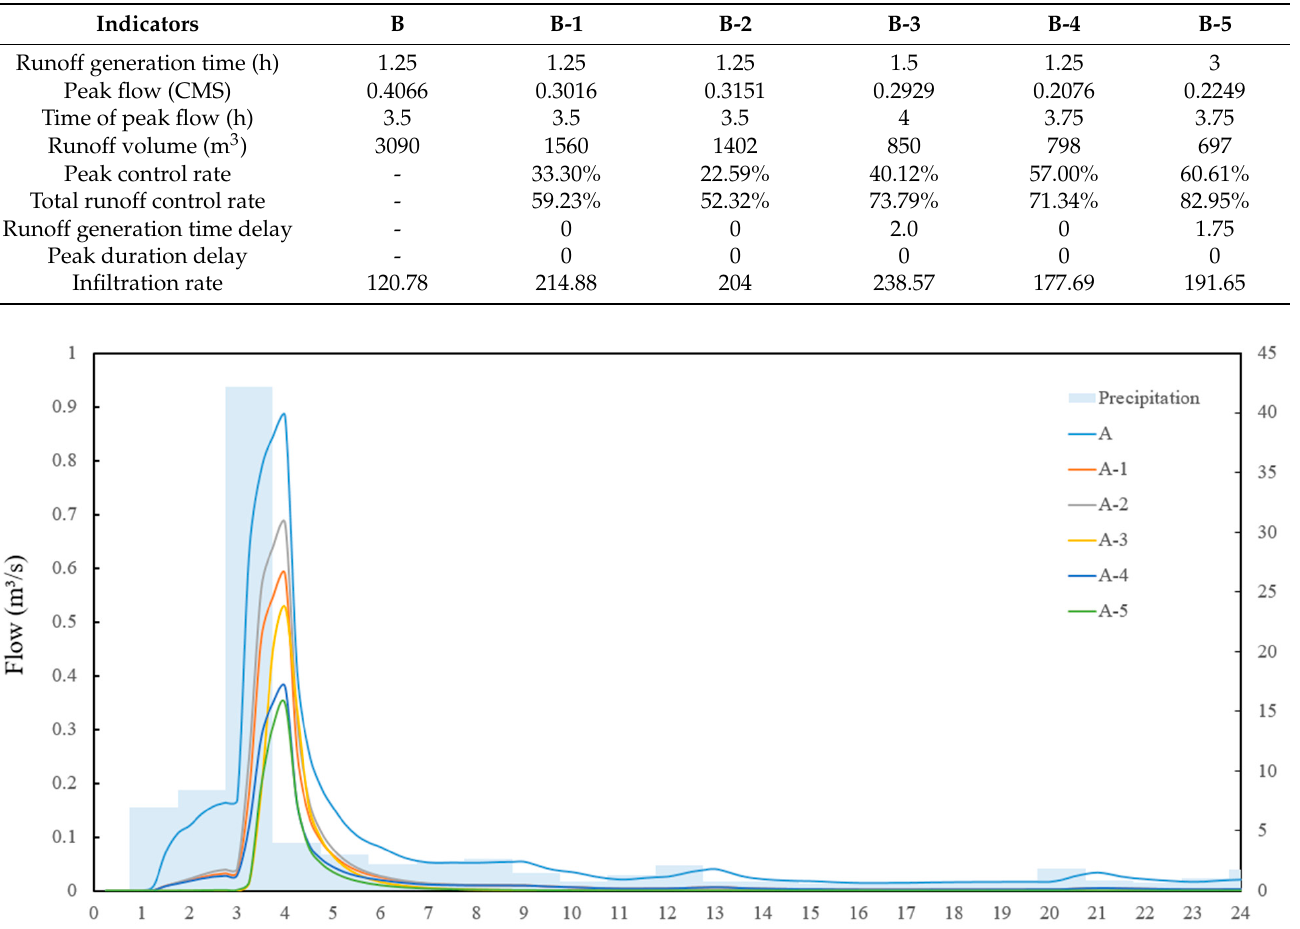
Table 6. Degree of performance improvement for 5 “what-if” scenarios in axial mode compared to the current situation.